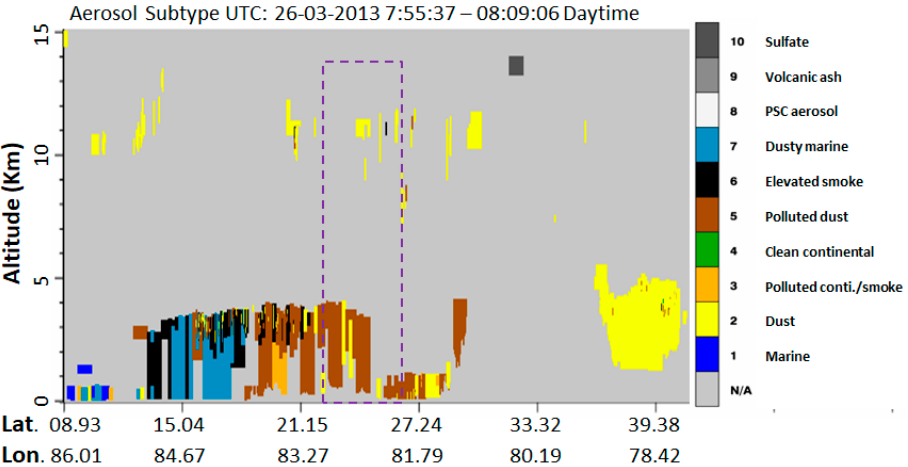
Figure 9. Cloud-Aerosol Lidar and Infrared Pathfinder Satellite Observation (CALIPSO) satellite aerosol types, and vertical distribution recorded on 26 March 2013.